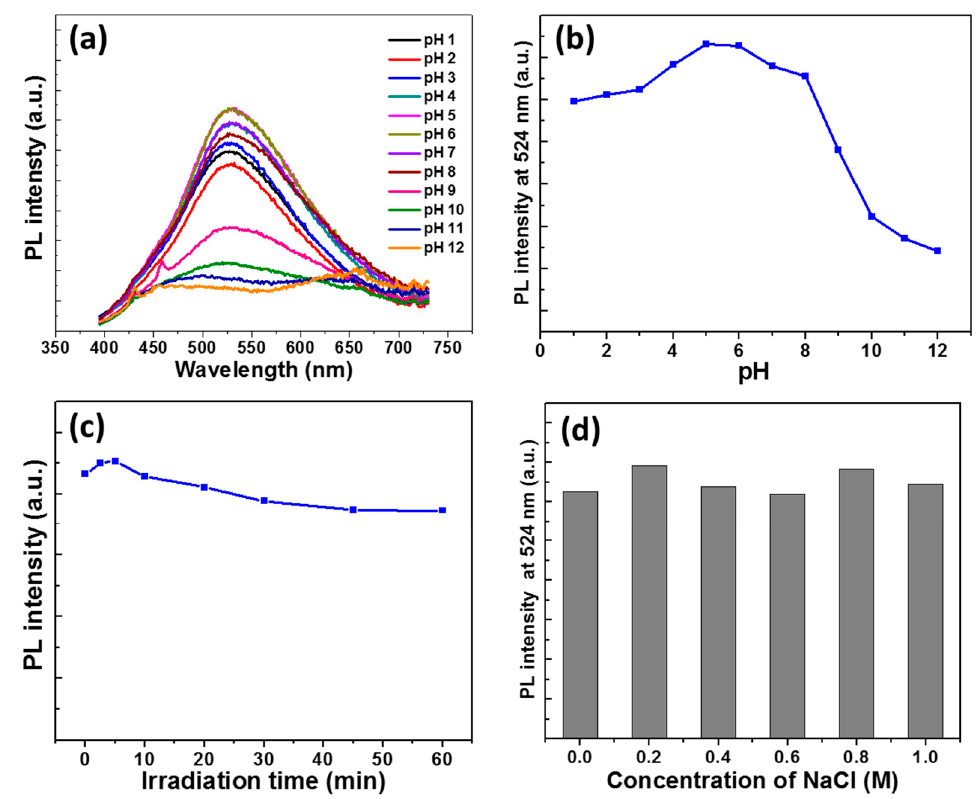
Figure 6. ( a ) PL emission spectra of GQDs when varying the pH from 1 to 12, ( b ) Evolution of GQDs PL intensity when varying the pH from 1 to 12, ( c ) Photostability of GQDs (Hg / Xe lamp, intensity of 100 mW / cm 2 ), and ( d ) PL intensity of GQDs in NaCl solutions with concentrations varying from 0.2 to 1 M.